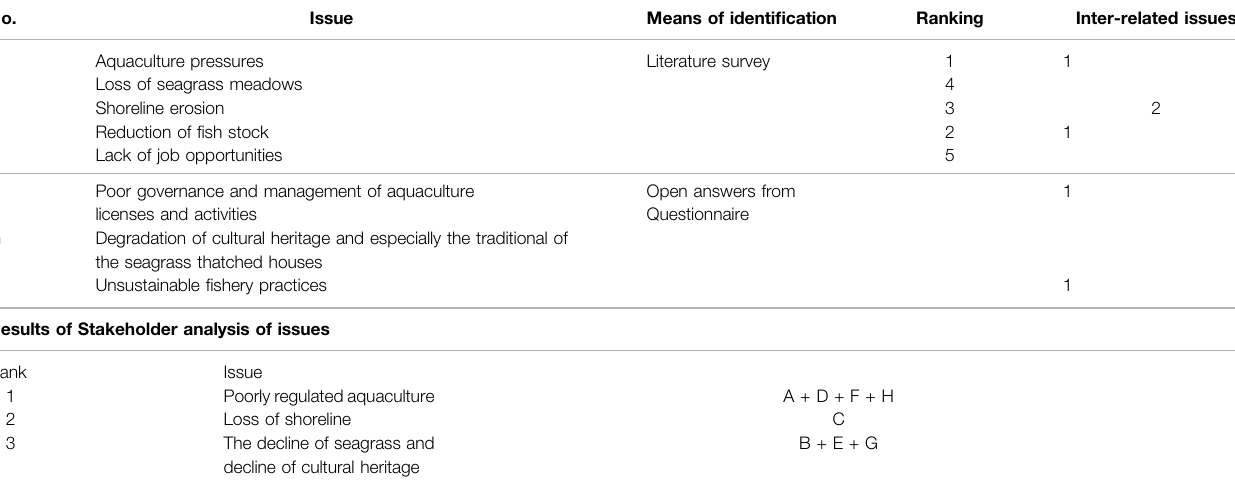
TABLE 3 | Ranking and integrating of